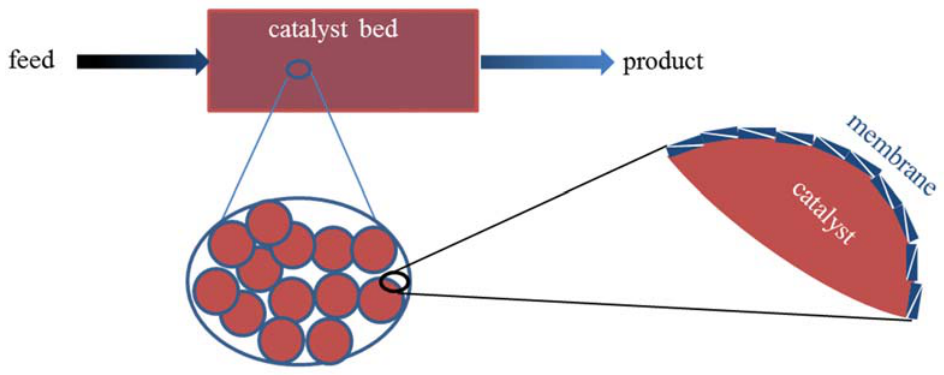
Figure 9. Catalyst bed filled with core-shell particles whereas each of them can be understand as zeolite membrane